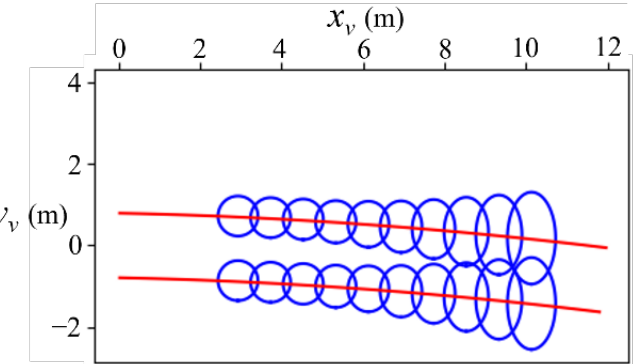
Figure 6. The reckoned trajectory and uncertainty distribution in the vehicle coordinate system.